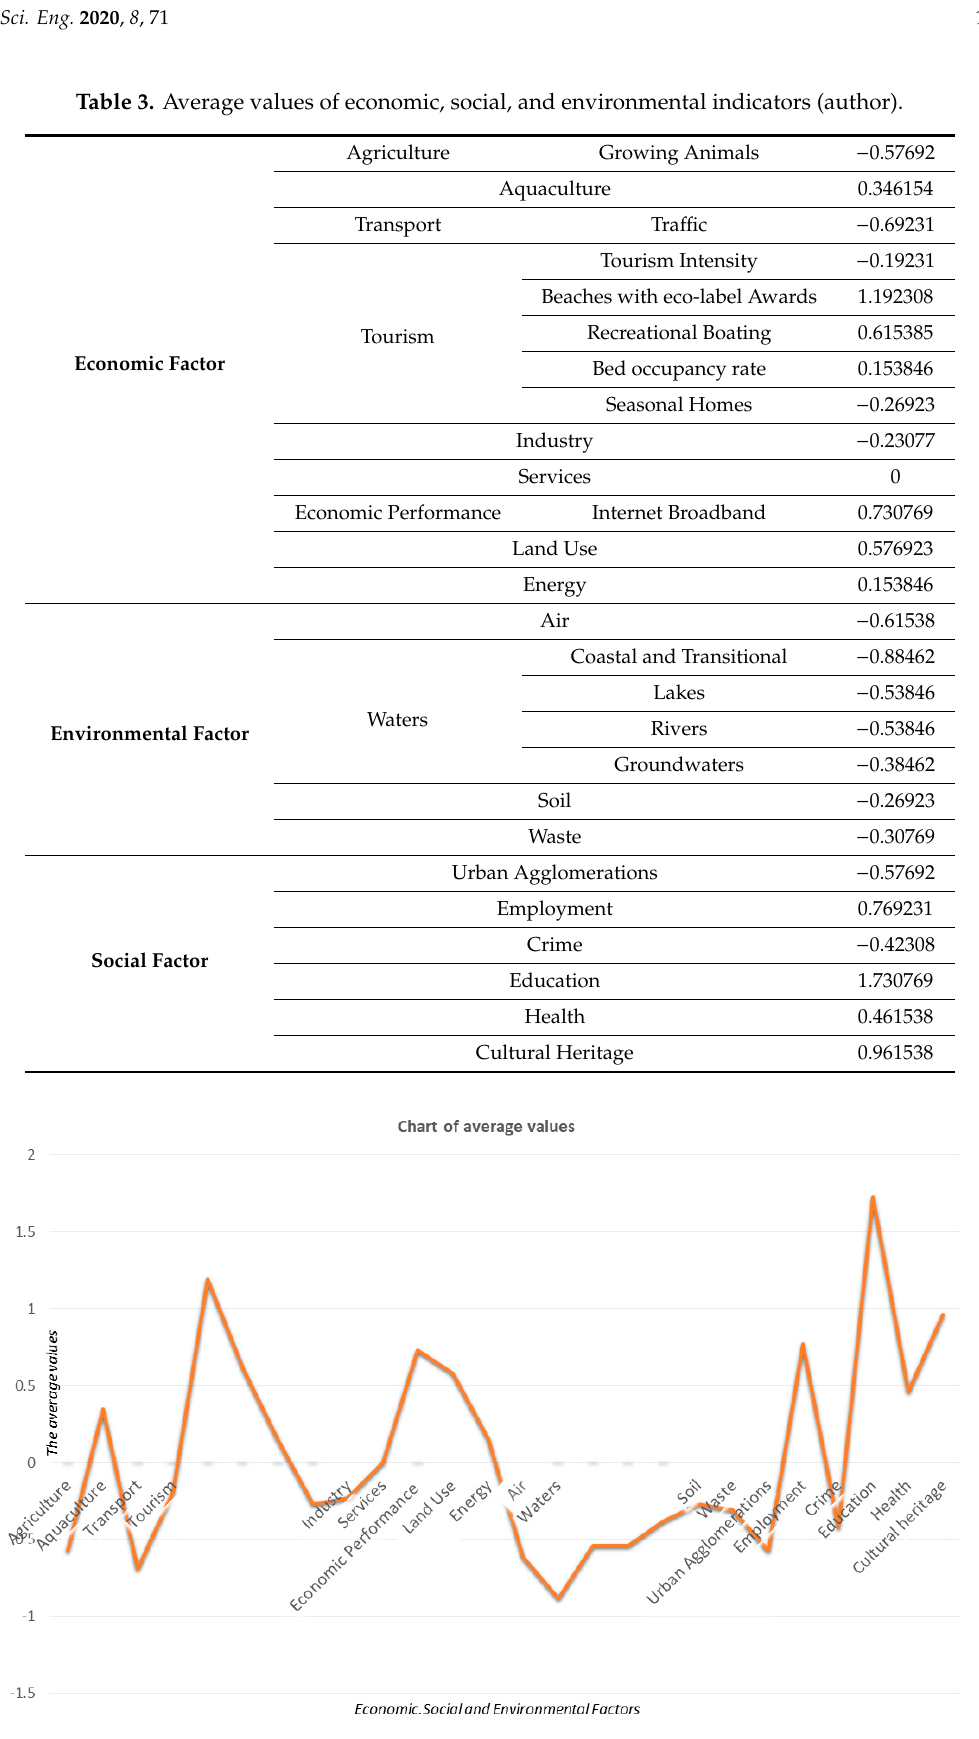
Figure 7. Average values of economic, social, and environmental indicators (author). -0.6-0.4-0.200.20.40.6 Figure 8. Average value for each factor (author). 4. Discussion The Organization for Economic Cooperation and Development has stated that the overall objective of integrated coastal zone management is to maximize the benefits offered by the coastal area and to minimize the conflicts and harmful effects of some activities on others. Coastal management focuses on the interactions between activities in the coastal area and activities in other regions. The present work aimed to identify an integrated management model that, on the one hand, can be applied to the particularities of the Kinvara Bay area and, on the other hand, can be applied to other situations. Analyses of each of these situations started from the particularities of the analyzed area, using a matrix of economic, social, and environmental factors, to which other factors of the PESTEL analysis can be added (i.e., political, legislative, and technological factors). Validation over time is absolutely necessary for the new model created. This should be done periodically through a multicriteria analysis to identify changes in the components of the analyzed factors. Within the analysis, local, regional, national, and international objectives should be